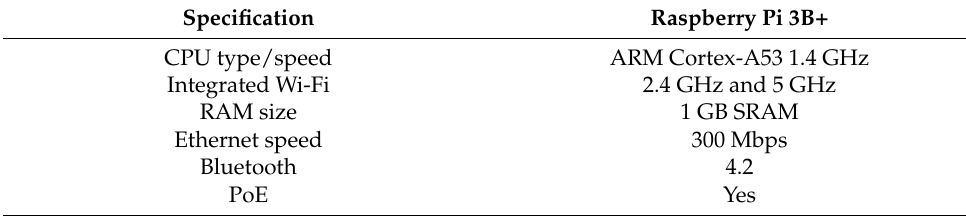
Figure 6. ( a ) 3D printer connected to the Raspberry Pi; ( b ) Raspberry Pi 3B+. Table 3. Raspberry Pi Specification